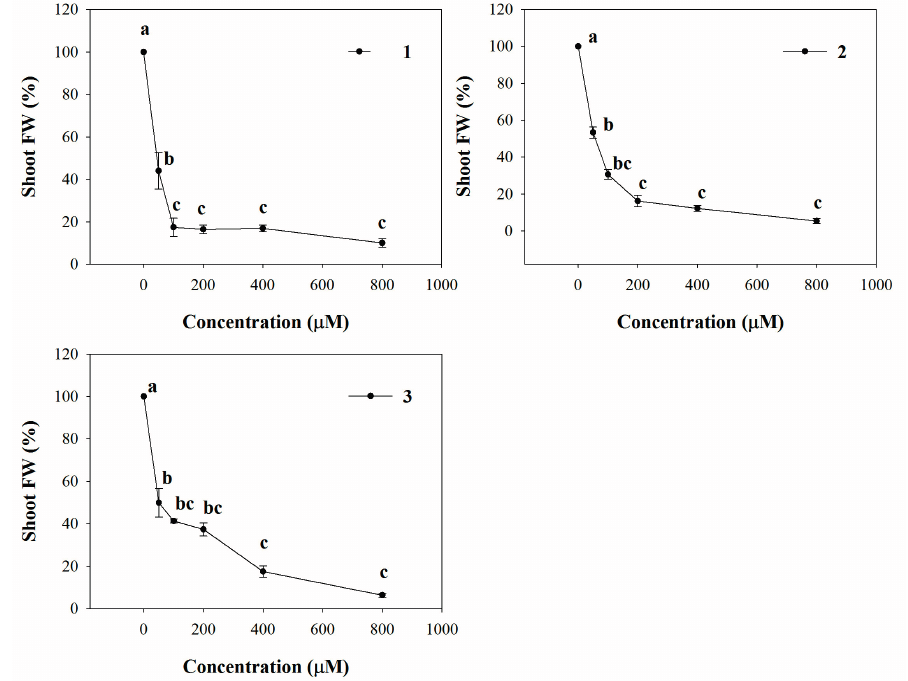
Figure 1. Dose-response curves of shoot fresh weight (SFW) of A. thaliana seedlings treated with 1 – 3 for 15 days. Data are expressed as percentage of the control. Different letters (a–c) along the curves indicate significant differences at p ≤ 0.05). Homoscedastic data were analyzed by ANOVA with Tukey’s test, whereas the heteroscedastic ones were analyzed with Tamhane’s T2. N =